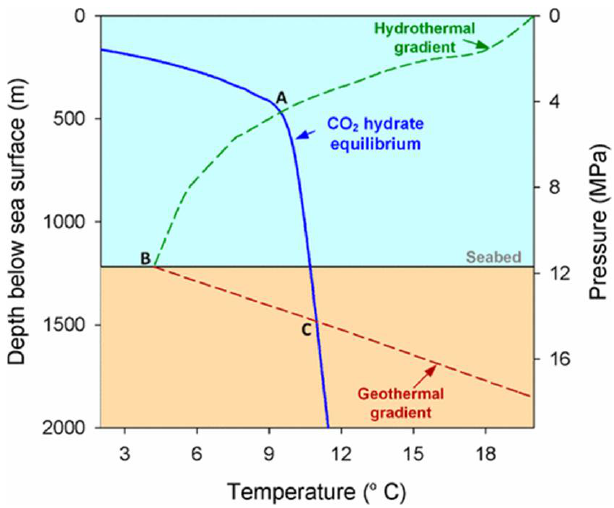
Figure 20. Hydrothermal gradient, geothermal gradient and CO 2 hydrate equilibrium. Reproduced with permission from [260], American Chemical Society, 2020.